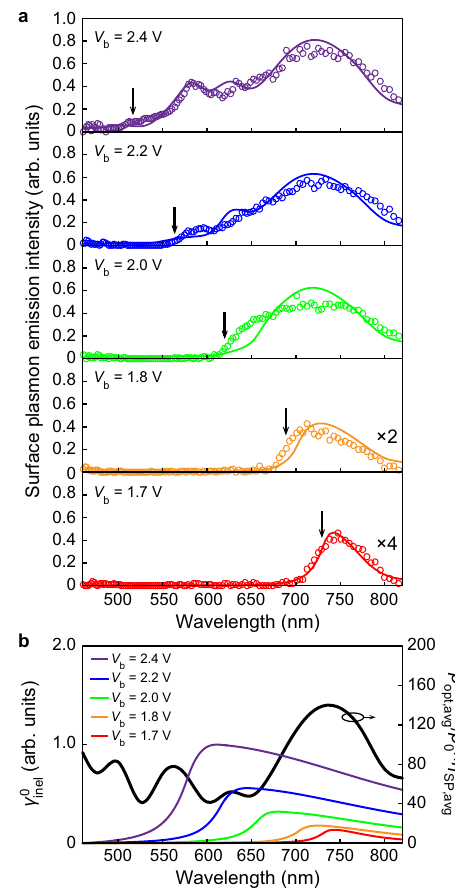
Fig. 4 Tunable SP emission spectrum. a Voltage dependence of the SP emission spectrum (colored dots) for a RIET device. For clarity, data at the two low voltages 1.7 V and 1.8 V are ampli fi ed by a factor of 2 and 4, respectively. Solid colored lines are the respective SP radiation power spectrum calculated based on the model described in the text, where the same scaling factors were used to match the experimental results. Black vertical arrows indicate the respective cutoff frequency v max with the quantum relation hv max ¼ eV b . Note that the small portion of emission with v > eV = h could be attributed to multielectron processes or hot-electron b light emission 50,51 . b Calculated vacuum source ef fi ciency γ 0 (color lines) inel = ρ ´ η and SP radiation enhancement ρ (black line) at various opt ; avg 0 SP ; avg voltages. Here, ρ and η were obtained under a dipole-source opt ; avg SP ; avg excitation with different polarization states and spatial positions, see Supplementary Note 3 for